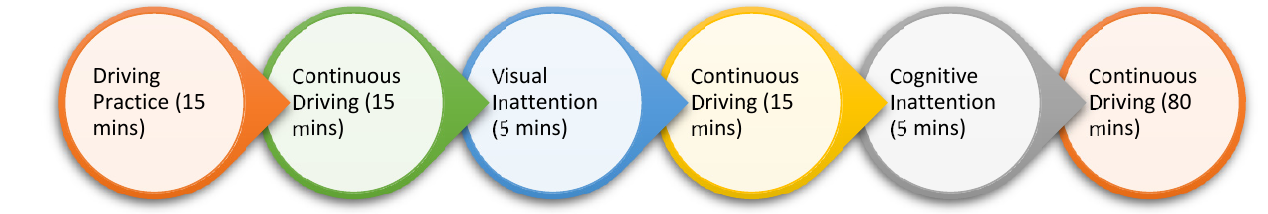
Figure 3. Protocol Figure 3 . Protocol design. Figure 3 . Protocol design.